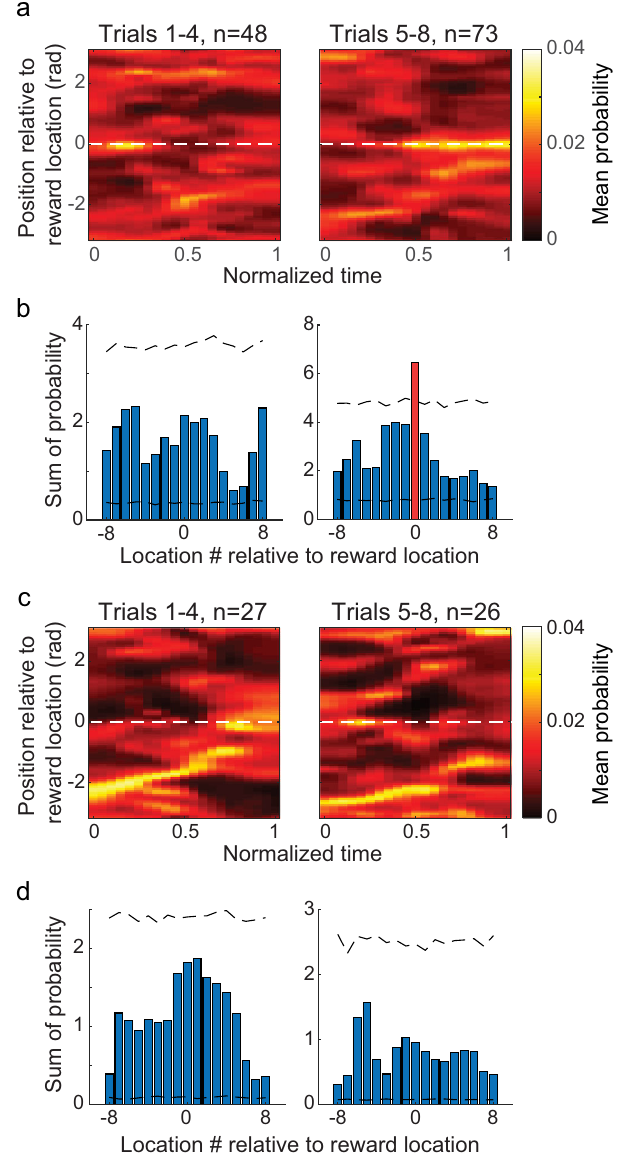
Fig. 7 A bias for replay events to terminate at the correct goal location emerged after learning during correct trials. a Mean posterior probabilities of replay events in correct trials. Replay events were aligned to the correct goal location on the vertical axis (i.e., location 0, white dashed line) and normalized time of replay event on the horizontal axis. b The sum of posterior probability for the last normalized time bin across replay events for each location number relative to the goal. Dashed black lines mark 95% con fi dence intervals of a null distribution generated by randomly shifting positions of each replay event (see Methods). A red bar marks the location number with a posterior probability sum that exceeded the corresponding 95% con fi dence interval (i.e., location 0, which corresponds to the correct goal location). c , d Same as ( a , b ) but for error trials. Note that no positions during error trials showed a posterior probability sum that was greater than the corresponding con fi dence